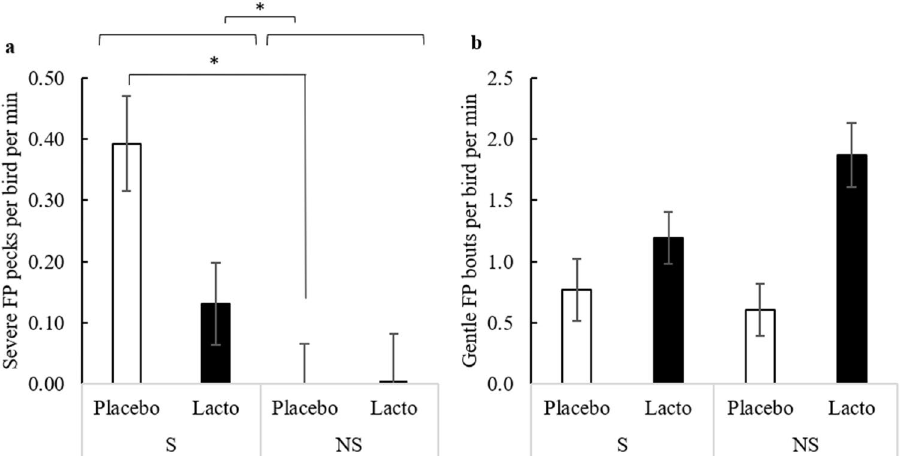
Figure 1. Expression of severe and gentle feather pecking behavior. Frequency of severe ( a ) and gentle ( b ) feather pecks per minute (Least Squares Means ± Standard Error) between weeks 24 and 26 based on supplementation (Lacto: L. rhamnosus , Placebo: Placebo supplementation) and stress (S: stressed, NS: non- stressed) treatment (n: S-Placebo = 22, NS-Placebo = 22, S-Lacto = 20, NS-Lacto = 22). Asterisks (*) indicate statistically significant differences (P < 0.05).